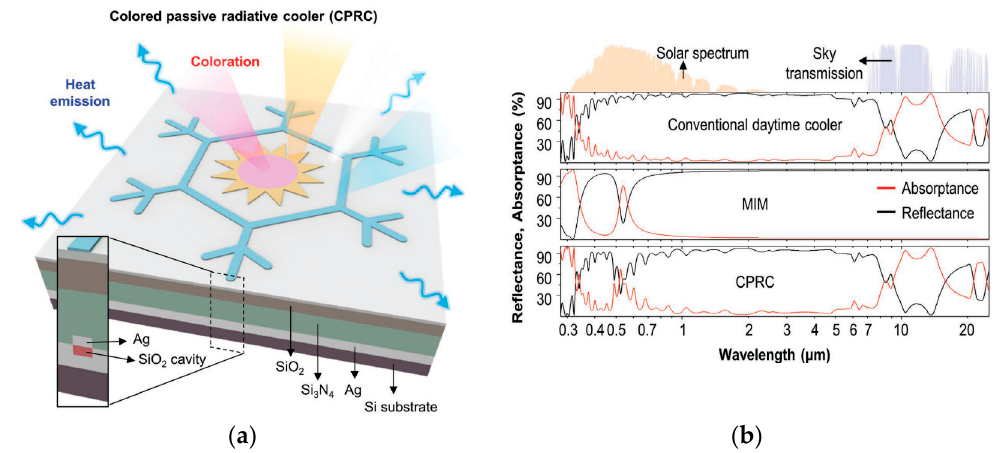
Figure 32. ( a ) Colored passive radiative cooler and ( b ) reflectance and absorption spectra for con-